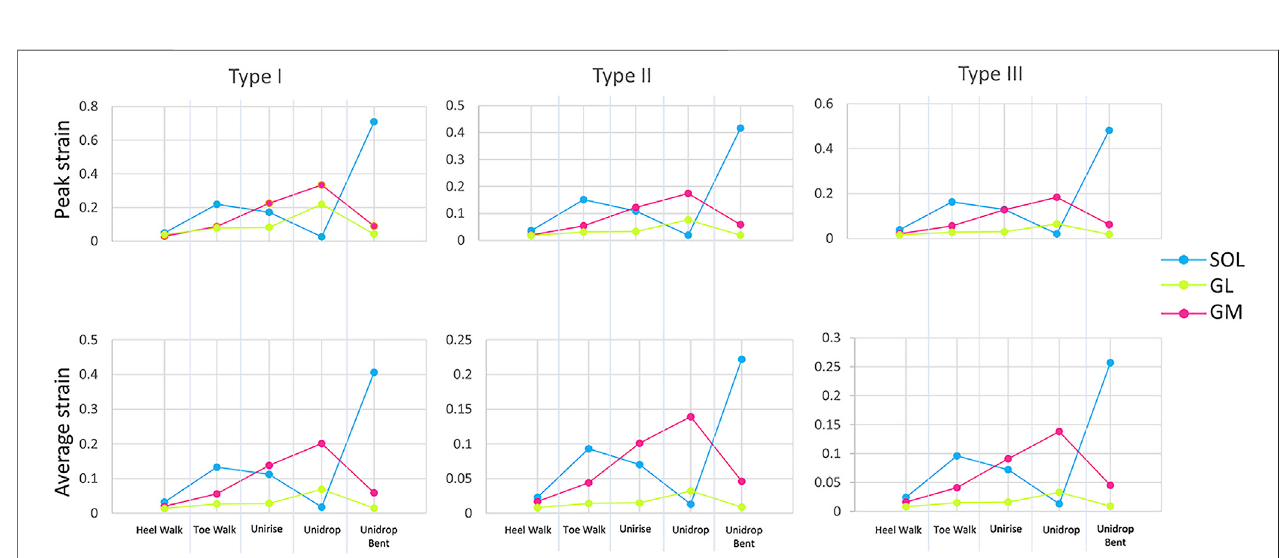
FIGURE 3 | Peak and average of the maximum Lagrange strain at the mid-portion of each sub-tendon, soleus (SOL), gastrocnemius medialis (GM) and gastrocnemius lateralis (GL), for all the fi ve rehabilitation exercises and twist.